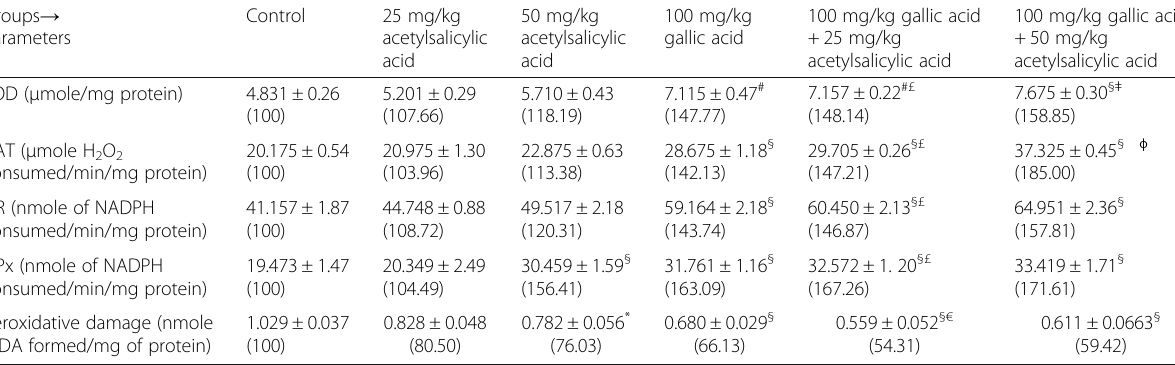
Table 3 Modulatory effects of gallic acid, acetylsalicylic acid and their combinations on specific activities of the hepatic antioxidant enzymes and magnitude of peroxidative damage in mice Groups →